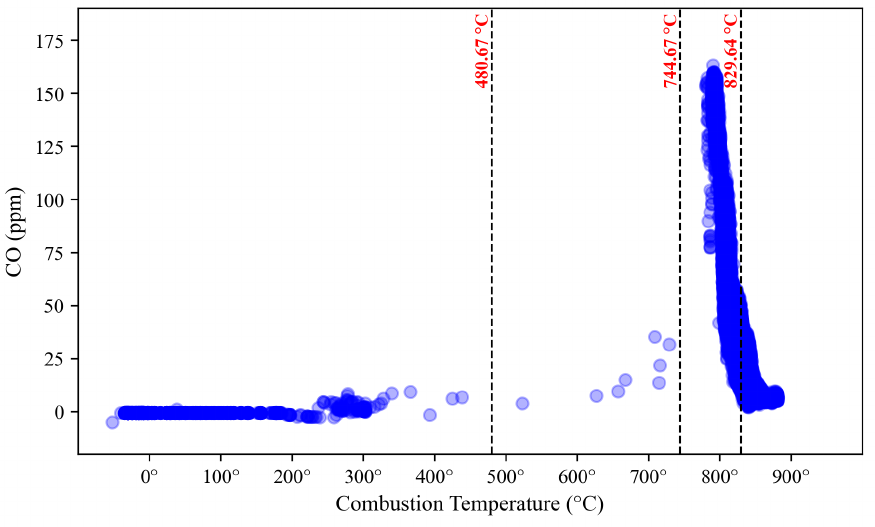
Figure 19. DLE gas turbine’s operating region based on CO emission